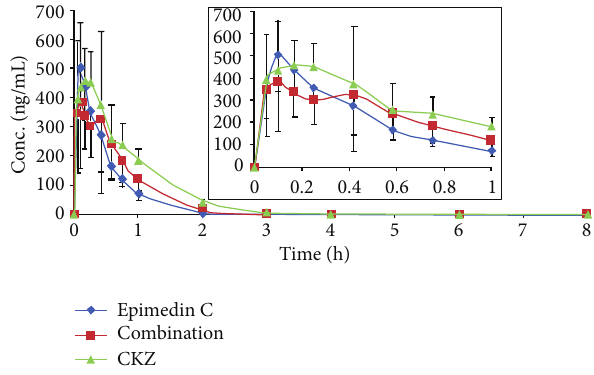
Figure 5: Mean plasma concentration-time profiles of epimedin C after intramuscular administration of epimedin C, combination of four flavonoid glycosides, and CKZ at the epimedin C dose of 0.33 mg/kg ( 𝑛 = 6